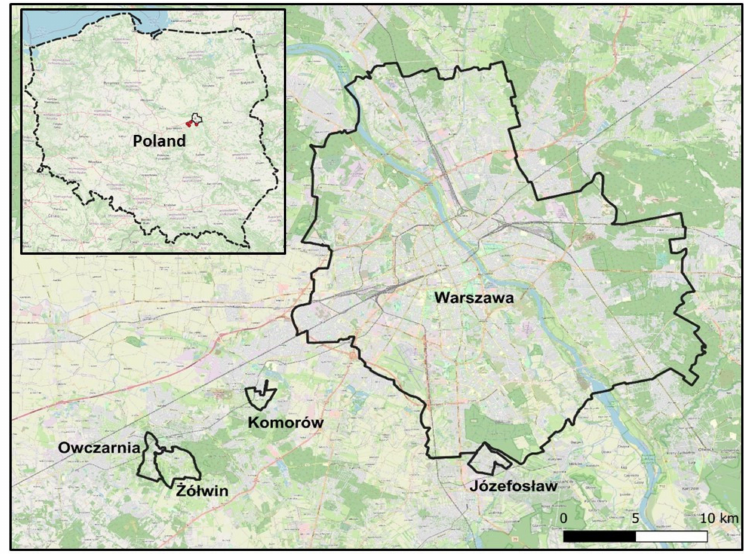
Figure 1. Location of the suburbs